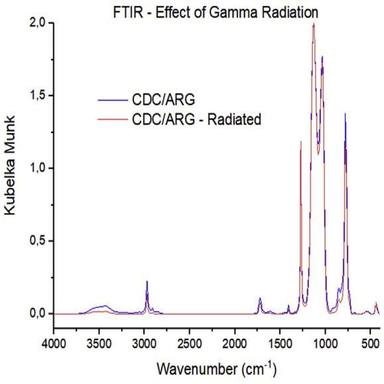
FTIR of CDC/ARG before and after gamma radiation exposure.